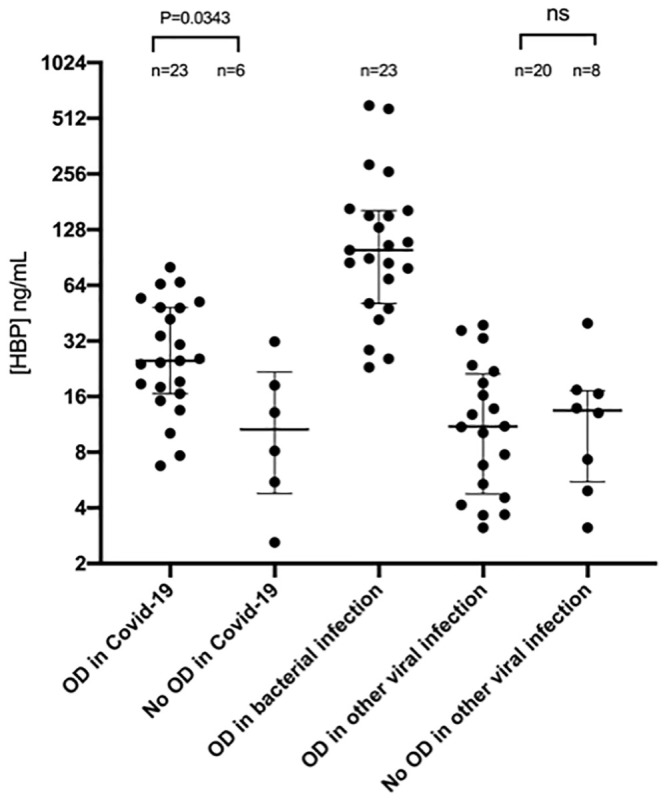
Plasma concentration of HBP in patients with severe COVID-19 and other sepsis.Plasma HBP levels measured by ELISA in patients with COVID-19, verified bacterial infection or other viral infection than COVID-19 with and without organ dysfunction (OD). Only one patient with bacterial infection did not have organ dysfunction and is not shown on the graph. HBP values in the COVID-19 cohort are the highest value measured in the first 72 hours from admission. Samples in the bacterial and other viral cohorts were taken at admission. Values were compared using Kruskal-Wallis test with Dunn’s post-hoc test for multiple comparisons.